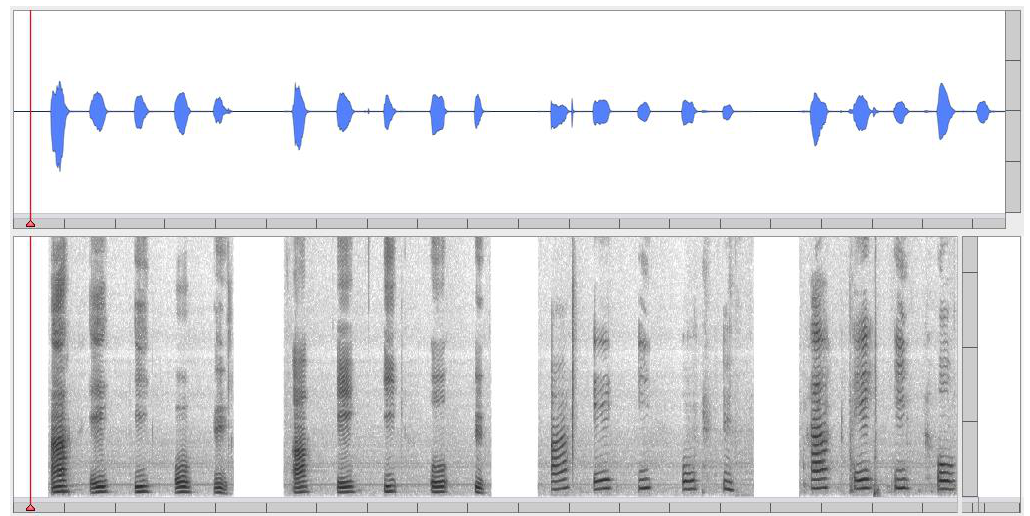
Figure 4. Analog-continuous depiction of the vowels / ɑ / /e/ / ɪ / /o/ /ü/ both as a waveform (upper pane) and a spectrogram (lower pane): two male voices (left) and two female voices (right).